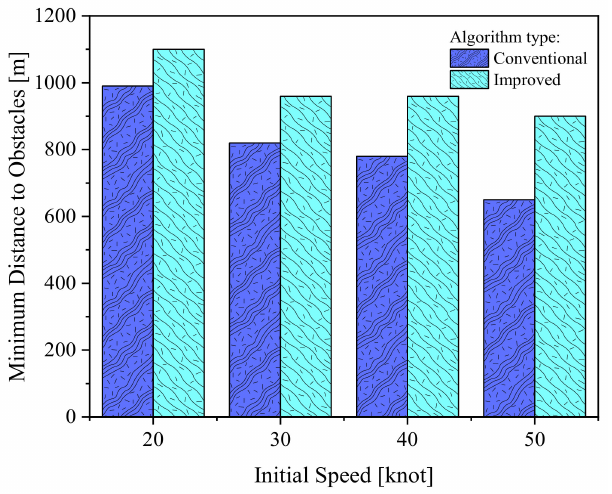
Figure 35. Recorded minimum distance from the USV to the obstacles based on GA type